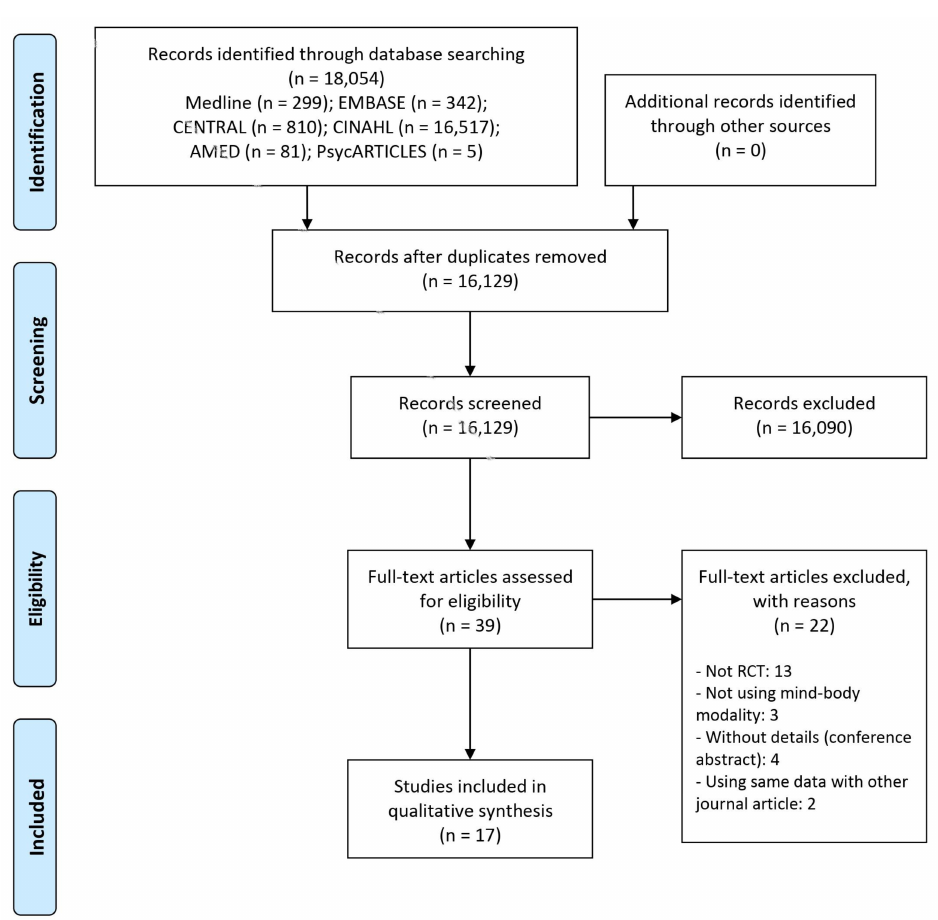
Figure 1. A PRISMA flow diagram of the literature screening and selection processes. AMED, Allied and Complementary Medicine Database; CENTRAL, Cochrane Central Register of Controlled Trials; CINAHL, Cumulative Index to Nursing and Allied Health